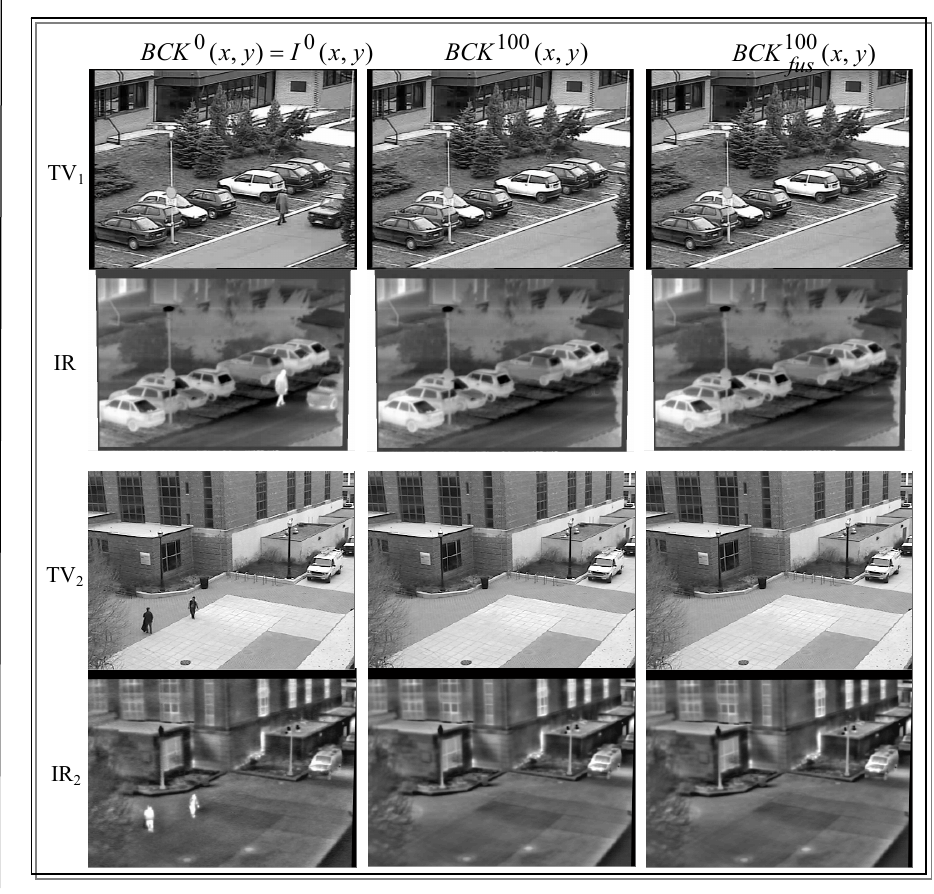
sekvence, a za inicijalne frejmove odabrani su frejmovi u kojima postoje pokretni objekti.